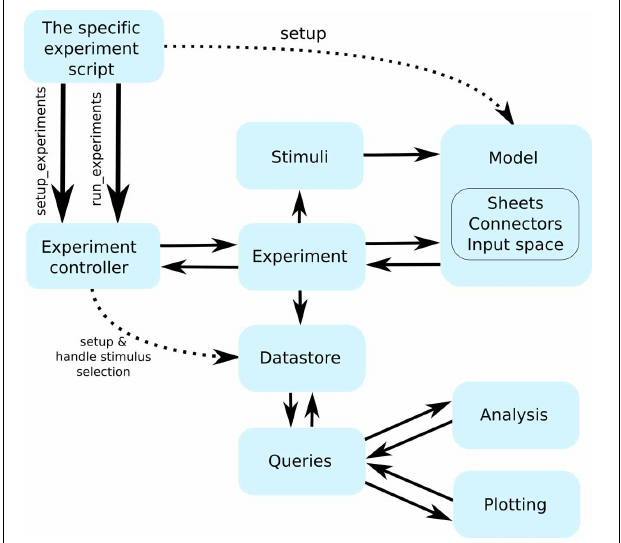
FIGURE 2 | The flow of control between the individual Mozaik components. Continuous arrows indicate flow of control between components, while interrupted arrows indicate initialization of component instances. The workflow is initiated from a user script with a single command that hands control to the Mozaik control hub (the experiment controller), which in turn initializes the model and data store based on the parameter files specified on the command line and proceeds with executing the list of specified experiments one by one. Each experiment specifies a list of stimuli, which it sequentially presents to the model, executing the model simulation for each of them. At the end of each stimulus presentation the experiment module receives back the recorded data, which it passes into the data store module. Once all experiments are executed, a script specifying the list of analysis and visualization procedures to be run over the stored data is executed. The analysis and visualization routines directly communicate with the data store via a query interface in order to retrieve and manipulate the stored